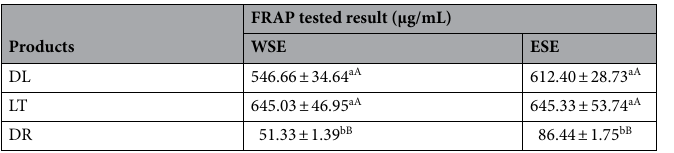
Table 4. Test results of ferric ion reducing antioxidant power (FRAP) tests for three products from Astragalus membranaceus (Fisch.) Bge. based on a V C standard curve. The data are means ± SD. The superscript different small and capital letters in the same column indicate significant and great significant differences at P < 0.05 and P < 0.01, respectively, according to multiple comparison results of ANOVA-Duncan. The abbreviation items are the same with Table 1.